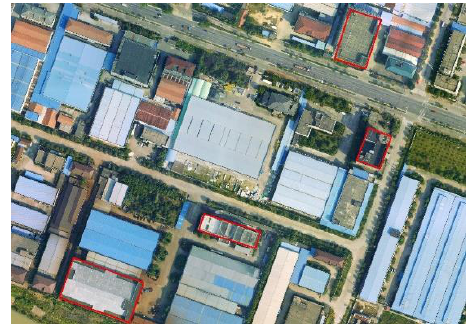
(c)Figure of the buildings that was misclassified to low-rise buildings checked by the Lidar points Figure 5. Results of the buildings quality inspection